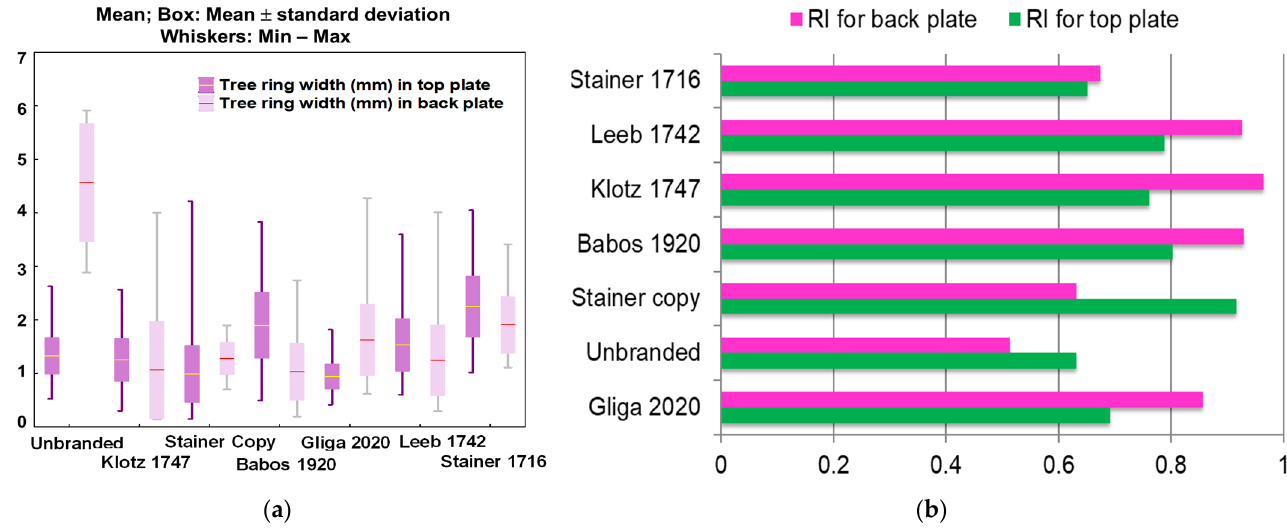
Figure 6. Comparison between anatomical descriptors of wood from old violins structures: ( a ) The variation of the annual ring width in case of top and back plates of studied violins; ( b ) The regularity level of the annual rings in the structure of the sound box for the analyzed violins.